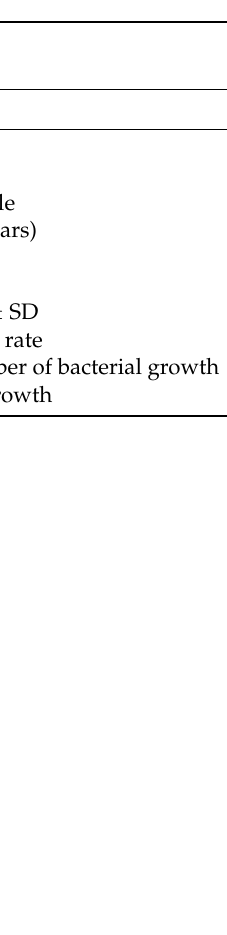
Table 1. Demographic characteristics of patients with infectious keratitis between 2004 to 2019.